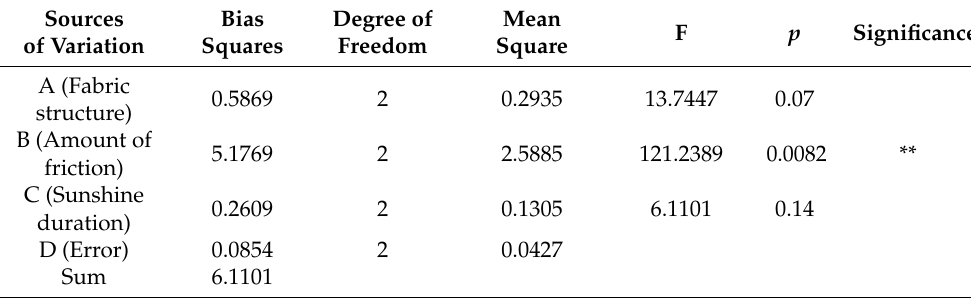
Table 10. Variance analysis of fabric structure and external